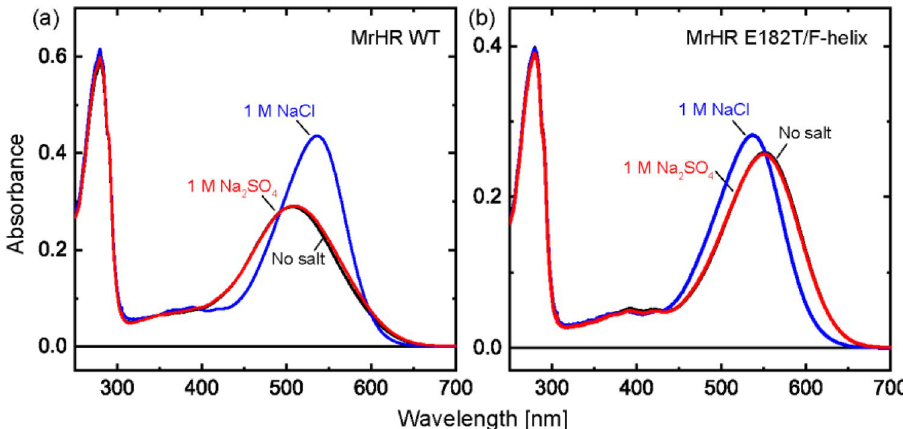
Figure 5. Absorption spectra of wild-type MrHR ( a ) and the E182T/F-helix mutant ( b ). The basal buffer was 50 mM citric acid, pH 6.0, containing 0.05%